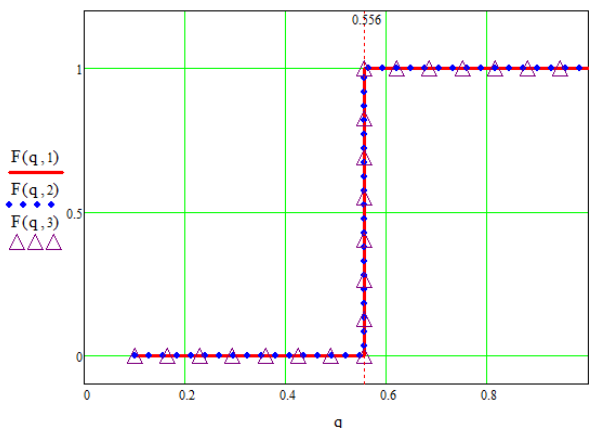
Figure 7. Graph of the logical function F (q,r) for different values of r.